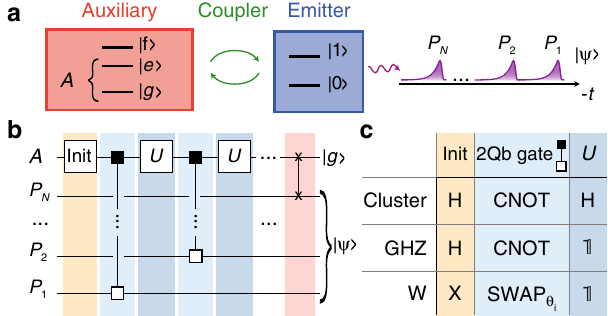
Fig. 1 Generation of entangled states of photons. a An auxiliary quantum system A coupled to an emitter is used to generate a state ψ modes P i . b Quantum circuit using an initialization gate and single-qubit gates U acting on the auxiliary system A , and two-qubit gates (small squares) of the CNOT and SWAP family between the auxiliary qubit and the photons P i . The last two-qubit gate is always a SWAP (crosses). c Speci fi c gates used for the generation of the cluster state, the GHZ state, and the W state. H: Hadamard gate, 1: Identity